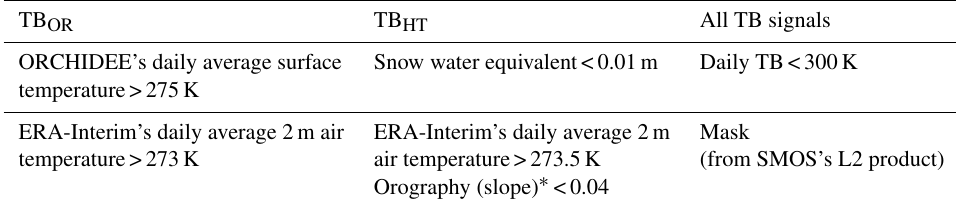
Table 3. TB filtering criteria to keep data, applied to the TB signals. TB OR TB HT All TB signals ORCHIDEE’s daily average surface Snow water